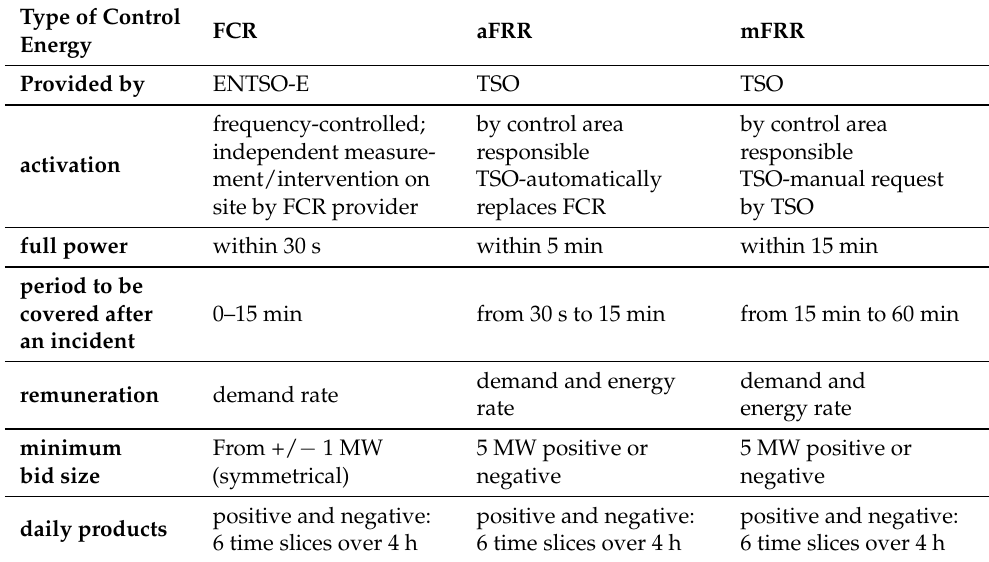
Table 1. The following table shows the different types of balancing energy and their